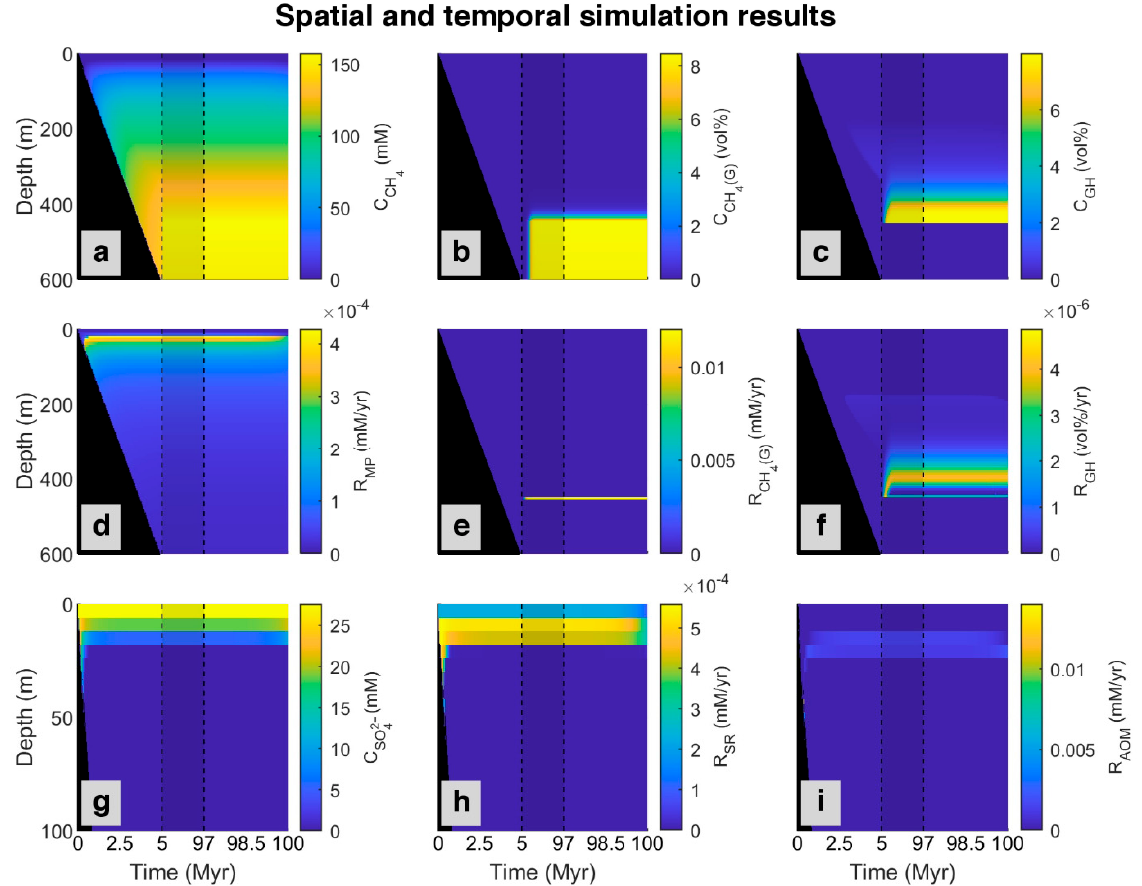
Figure 4. Spatial and temporal results of the model for the simulated ODP site 997 [49] magnified in the first 5 Myr and the last 3 Myr (plots without magnification are presented in Appendix A, Figure A1). First row: Concentration profile of ( a ) Dissolved methane (CH 4 ); ( b ) Methane in the gas phase (CH 4 (g)); ( c ) Methane in hydrate phase (GH). Second row: Simulated rates of ( d ) Methanogenesis (MP); ( e ) Free gas formation (CH 4 (G)), and ( f ) Gas hydrate formation (GH). Last row presented in shorter depth (to magnify the rate changes, which occur only at the upper part of the model): ( g ) Concentration profile of sulfate (SO 42 − ); simulated rate of ( h ) Sulfate reduction (SR), and ( i ) Anaerobic oxidation of methane (AOM). The black area refers to the place where no sedimentation occurred. The area limited by dashed lines represents changes from 5 to 97 Myr.